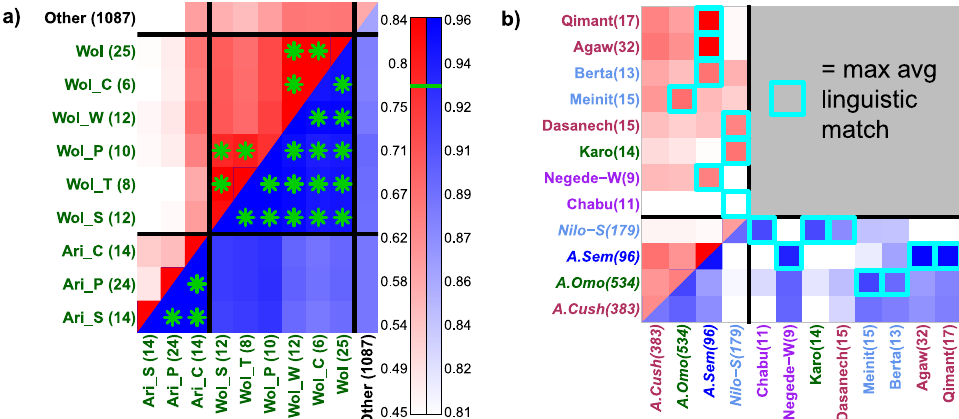
Fig. 2 Genetic similarity suggests recent endogamy within occupational groups and shows shared ancestry among some linguistically divergent groups. Average pairwise genetic similarity (1-TVD) between individuals from different Ethiopian labelled groups (coloured on axis by language category – see Fig. 1a), under the “ Ethiopia-internal ” analysis (top left, red colour scale) versus the “ Ethiopia-external ” analysis (bottom right, blue colour scale). a Genetic similarity between Ari and Wolayta (Wol) occupational groupings (C = cultivator, P = potter, S = blacksmith, T = tanner, W = weaver), with green asterisks denoting relatively high similarity above the green lines in legend at right. This illustrates how the “ Ethiopia-external ” analysis shows increased similarity between groups of the same ethnicity relative to that seen under the “ Ethiopia-internal ” analysis. b Average pairwise genetic similarity among individuals from four language classi fi cations (italics), and the average genetic similarity between individuals from these four language groups and those from eight ethnic groups (non-italics). For each of the eight ethnic groups, the cyan squares denote the language group with the highest average genetic similarity to that ethnic group under each analysis. This illustrates how the linguistically-unclassi fi ed Chabu and Negede-Woyto are most genetically similar on average to Nilo-Saharan and Afroasiatic Semitic speakers, respectively, and highlights six other groups that are more genetically similar to members from a different language group than they are to members of their own language